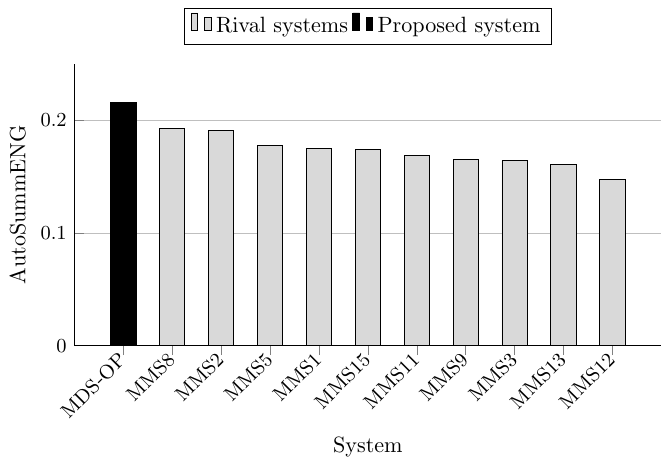
Figure 12. AutoSummENG scores on MultiLing 2015 (MMS